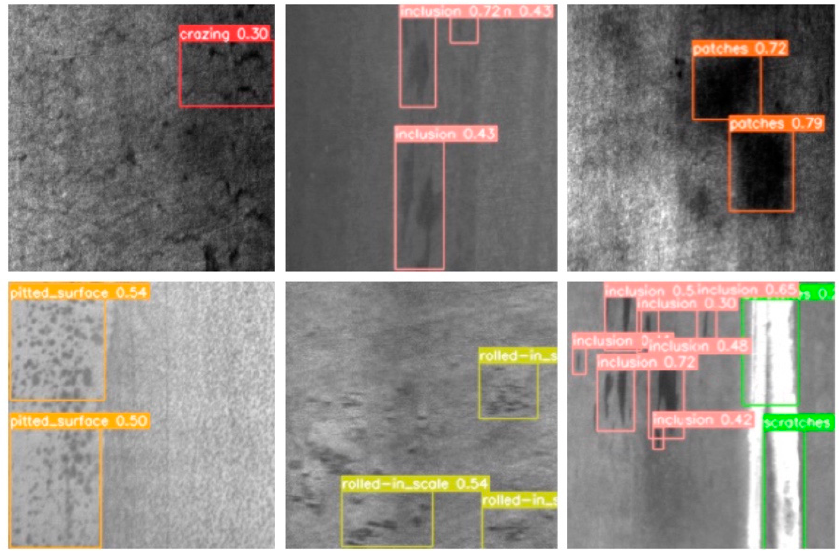
Figure 6. Some visualization results from our MSFT-YOLO on NEU-DET dataset; different categories use bounding boxes with different colors.